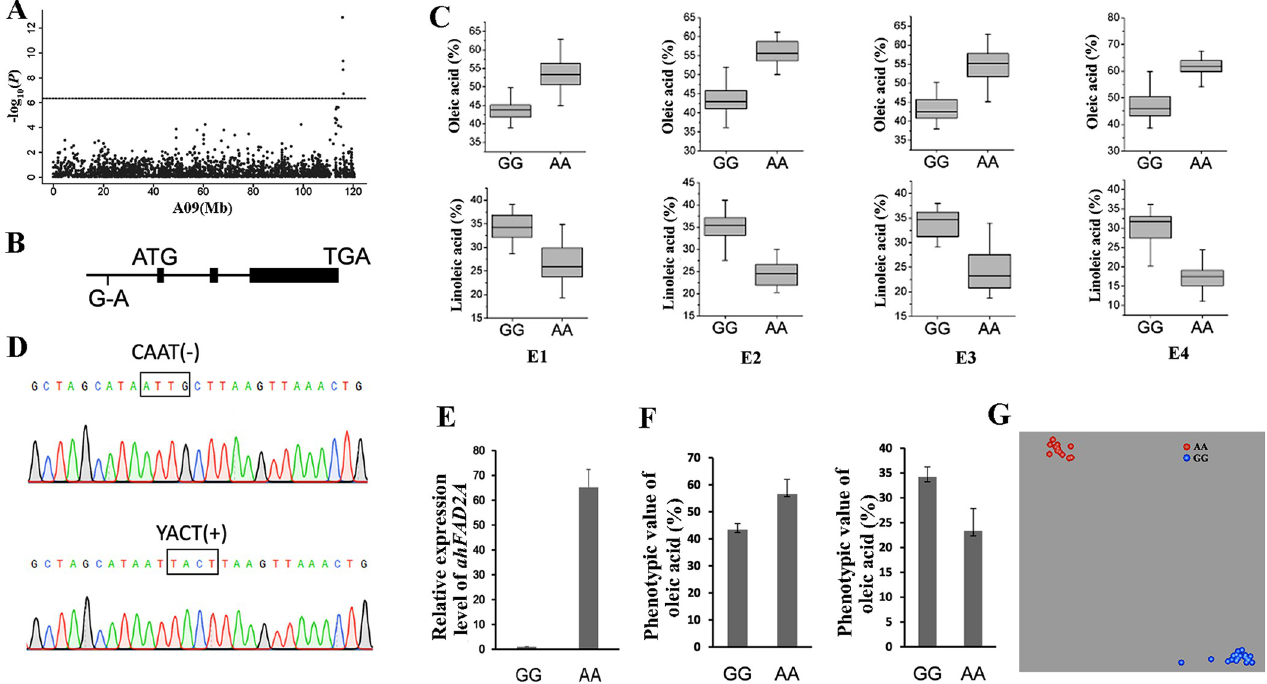
Fig 3. Genetic analysis of oleic acid and linoleic acid on A09 and validation of the diagnostic marker. (A) Take the Manhattan plots of A09 chromosome for oleic acid (C18:1) in E1 environment as an example. (B) The diagram of SNP (G-to-A) in the promoter region of ahFAD2A . (C) The allelic effect at A09- 114690064 for oleic acid (C18:1) and linoleic acid (C18:2) under four environments. For each trait, the boxes with GG alleles and AA alleles were significant different according to Tukey’s Multiple Comparison Test ( P < 0.05) (D) The partial sequence diagrams included the diagnostic locus of the SNP in the promoter of ahFAD2A after amplifying by PCR and sequencing. The diagnostic SNP locus changed the cis-element of CAAT (-) to enhancer-like module YACT (+). (E) qRT–PCR result of ahFAD2A in seeds at stage 7. (F) Phenotypic differences between accessions carrying different alleles of the SNP A09- 114690064 of two extreme trait groups of peanut. P < 0.001, Student’s t-test. (G) Scatter plots using KASP marker